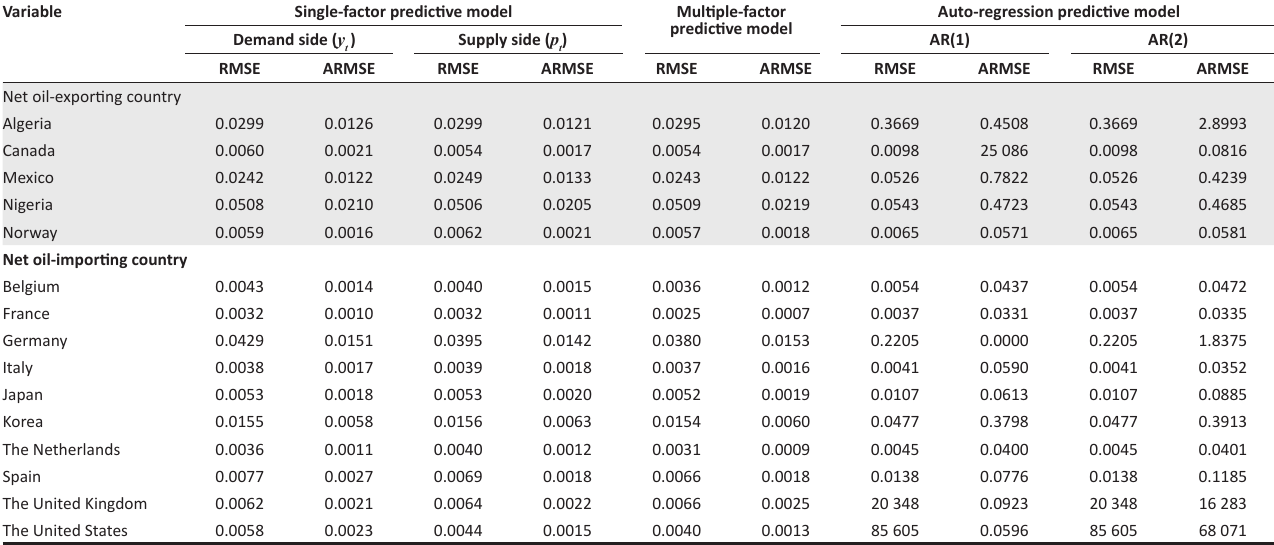
TABLE 5: In-sample forecast performance using the root mean square error and adjusted root mean square error (75% sample size).